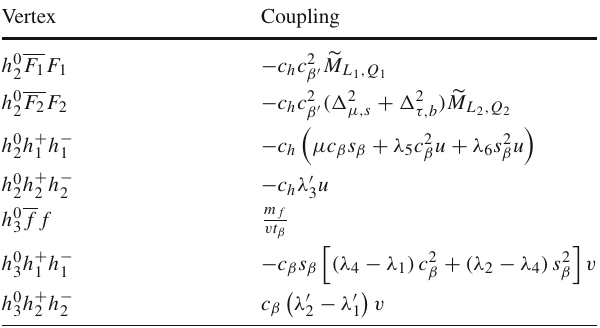
with fermions and charged 2 , 3